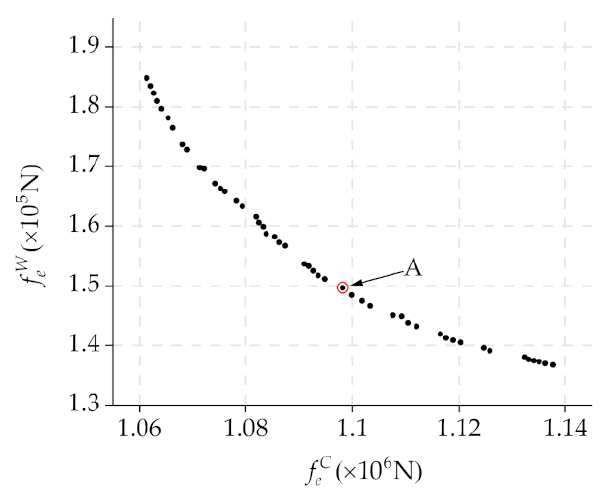
Figure 21. The Pareto front of optimization results.